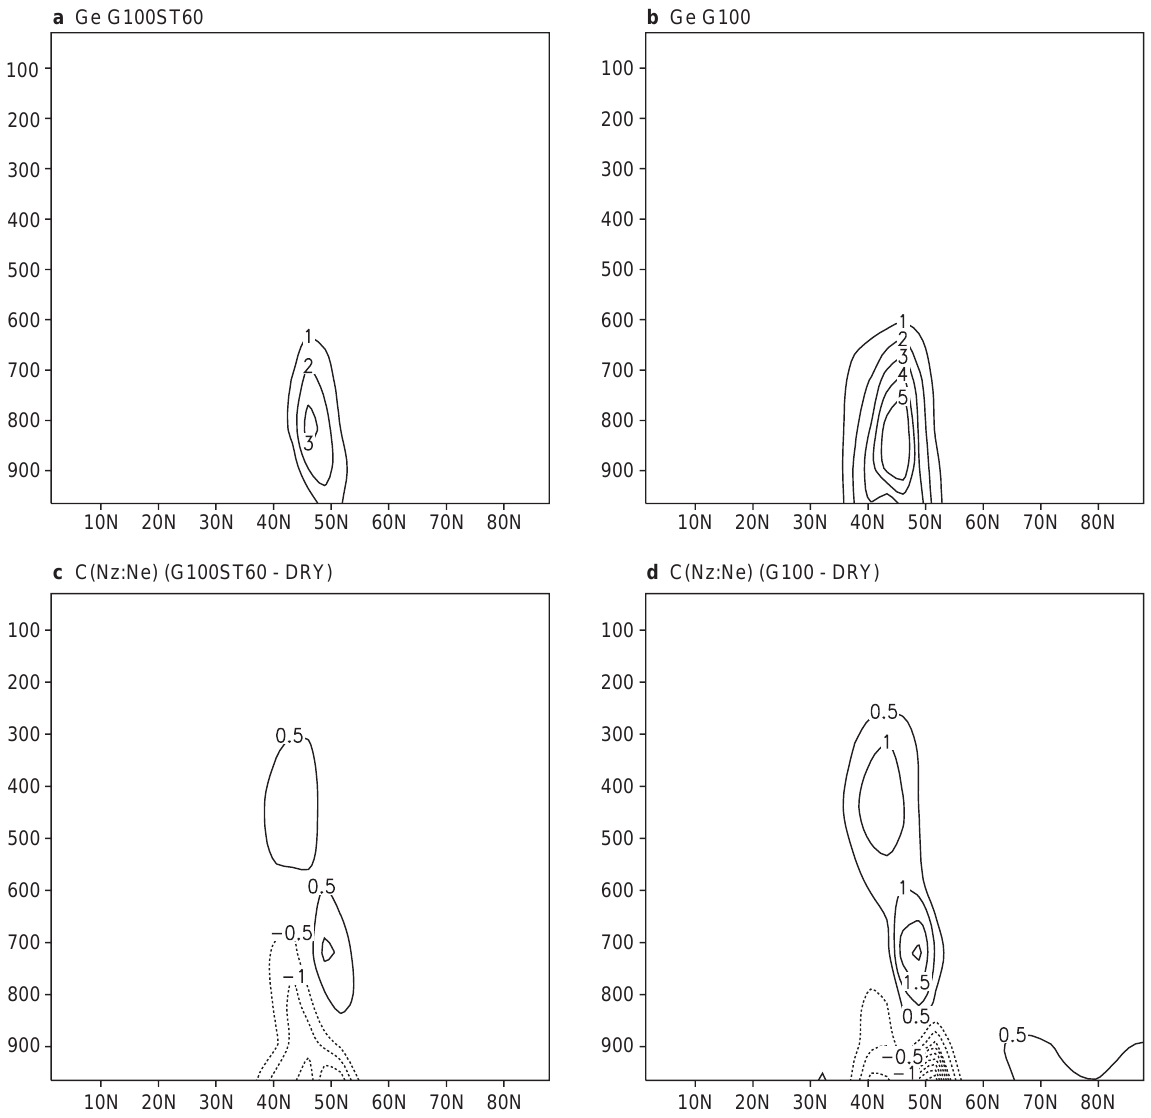
Fig. 7a,b The average spatial distribution over days 5 to 7 of the integrand of the diabatic source term G e , for a G100ST60 and b G100. Contours every 10 5 J m (cid:255) 2 per day. c, d . The average spatial distribution over days 5 to 7 of the integrand of the conversion from